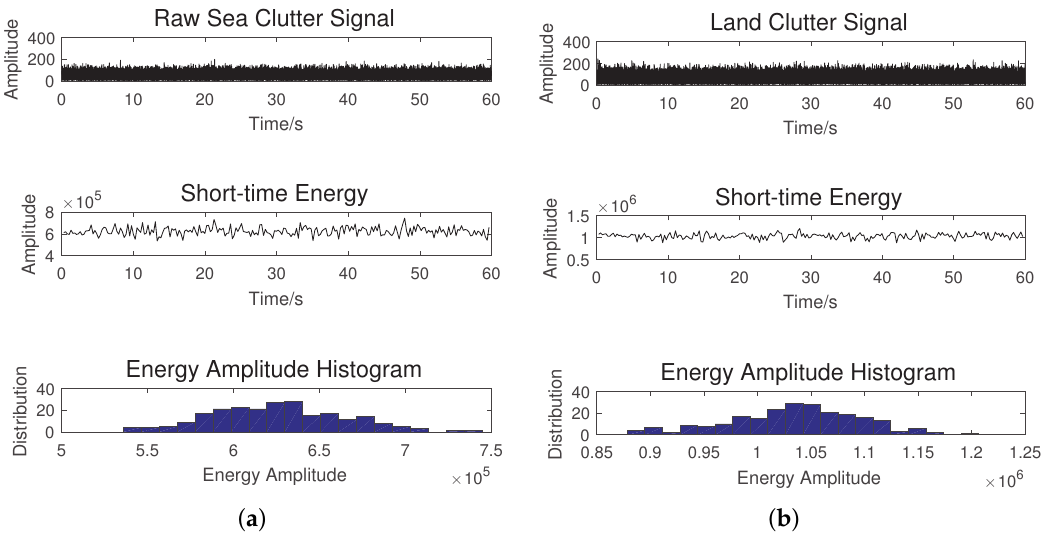
Figure 2. ( a ) Short time energy of the sea clutter; ( b ) short time energy of the land clutter.